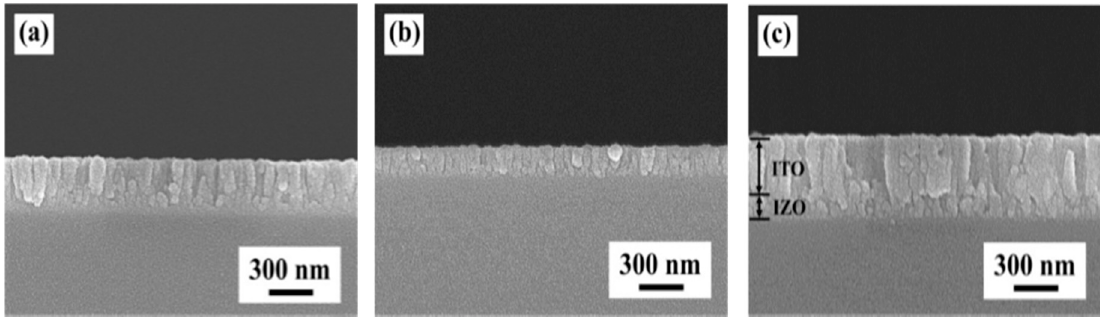
Figure 3. Cross-sectional SEM images of the thin films: ( a ) ITO/Si; ( b ) IZO/Si; and ( c ) ITO/IZO/Si. The X-ray diffraction (XRD) patterns of the ITO and IZO films deposited on the Si substrate are presented in Figure 4. The diffraction peaks at 2 θ values of 21.4°, 30.3°, 35.1°, 37.2°, 41.7°, 45.4°, 51.6°, 55.6°, and 60.4° in Figure 4a correspond to the (211), (222), (400), (411), (332), (431), (440), (411), and